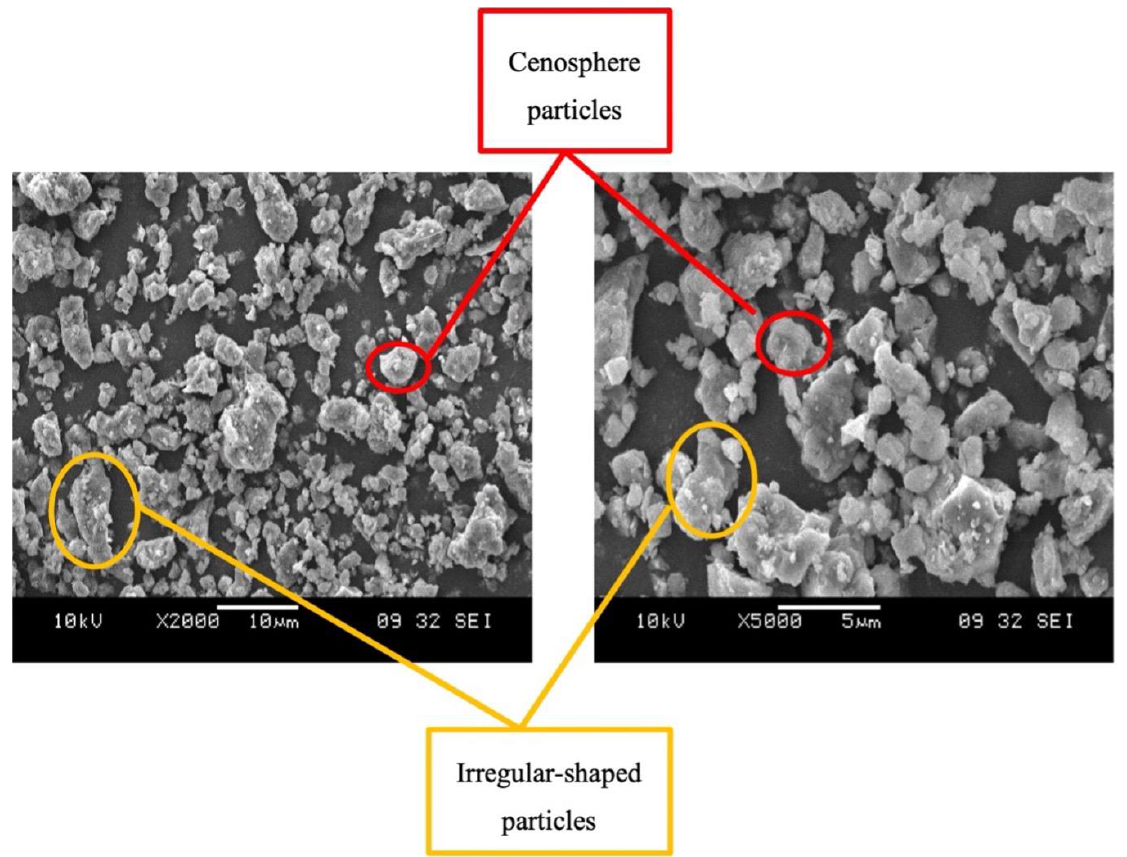
Figure 6. SEM micrographs of the raw high calcium pozzolanic at 2000× and 5000× magnification.